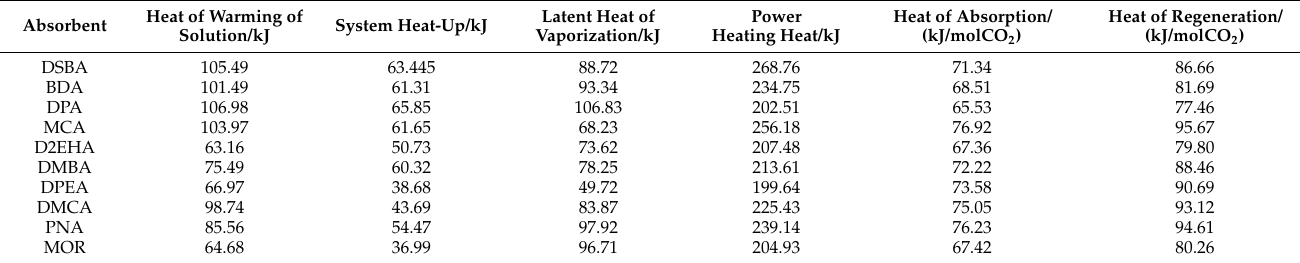
Table 4. Test table of reaction heat of 1mol/L critical amine.